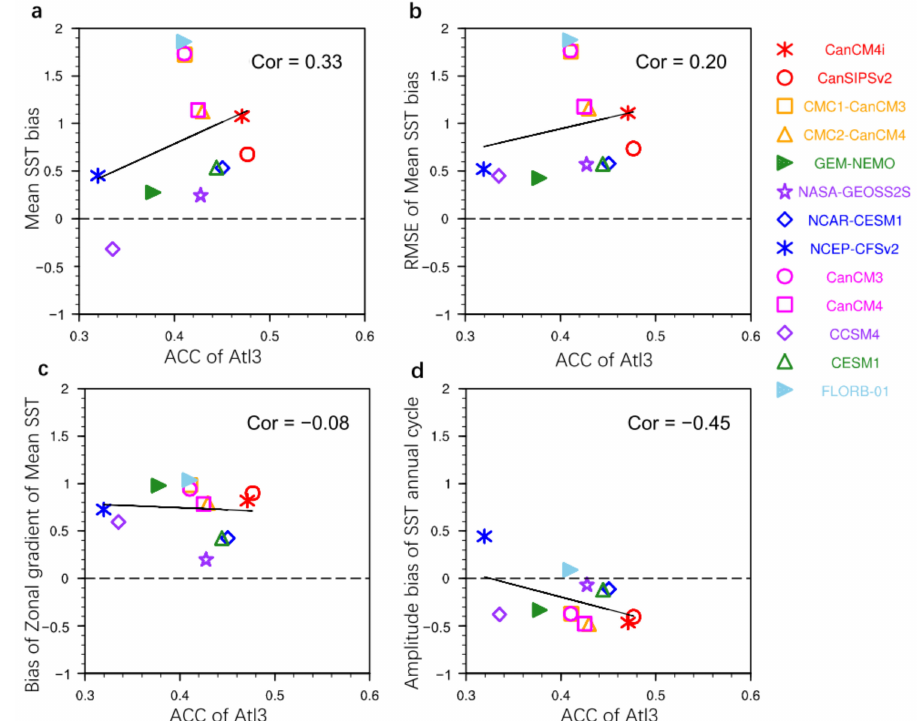
Figure 14. Scatter diagram shown the relationship between the ACC of Atl3 index ( x -axis) and ( a ) mean SST bias averaged over Atl3 region, ( b ) the RMSE of mean SST biases averaged over Atl3 region, ( c ) the bias of zonal gradient of mean SST, ( d ) the amplitude bias of the annual cycle of SST averaged over Atl3 region. The linear regression line is presented and the correlation coefficient is shown on the top right of each panel. Note that the relationship shown here are derived from the four-month-lead forecast, which resemble those at different lead